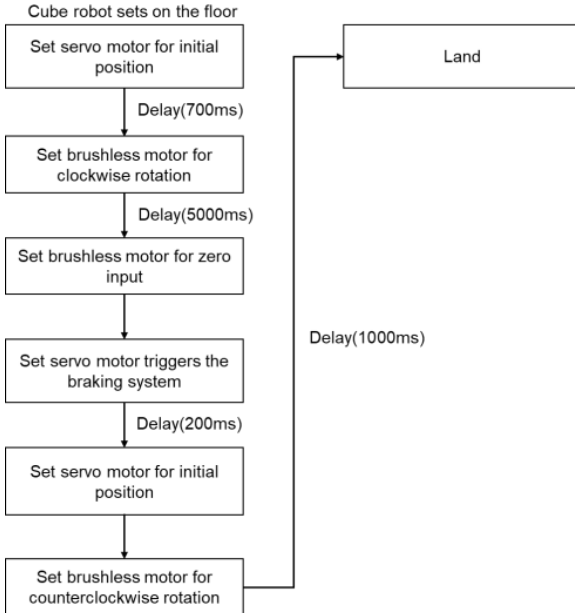
Figure 13. The flow chart of the cube robot bouncing control.